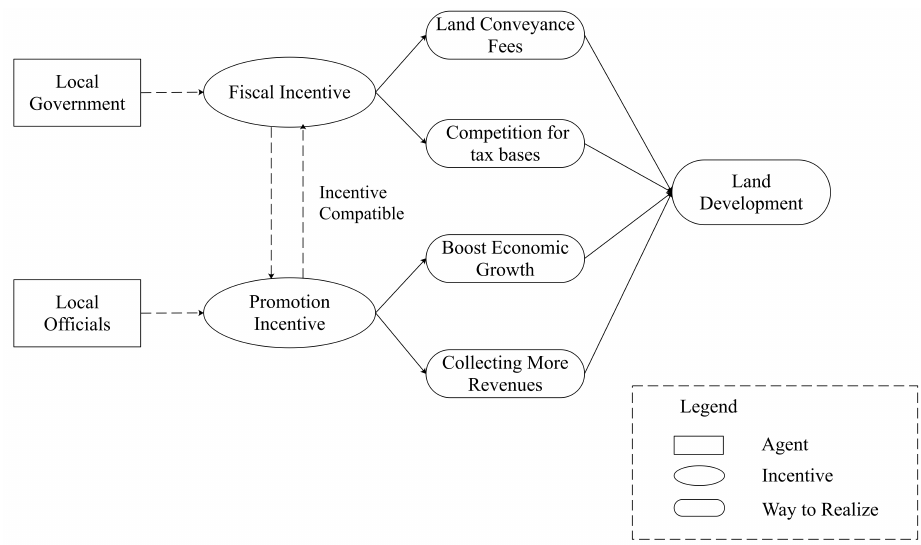
Figure 1. Incentives of local government and